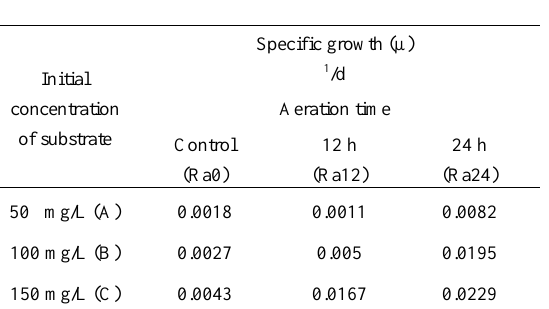
Table 1. Effect of glucose concentration and aeration time on specific growth